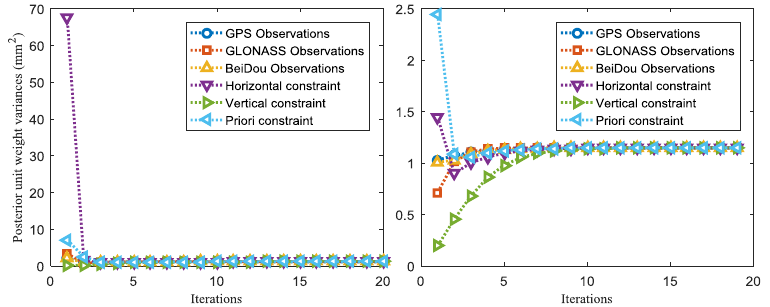
Figure 2. The change of posterior unit weight variances for six types of equations with iteration for Scheme 2 at date UTC 12:00 p.m. Doy 303, UTC 12:00 p.m., 2015.